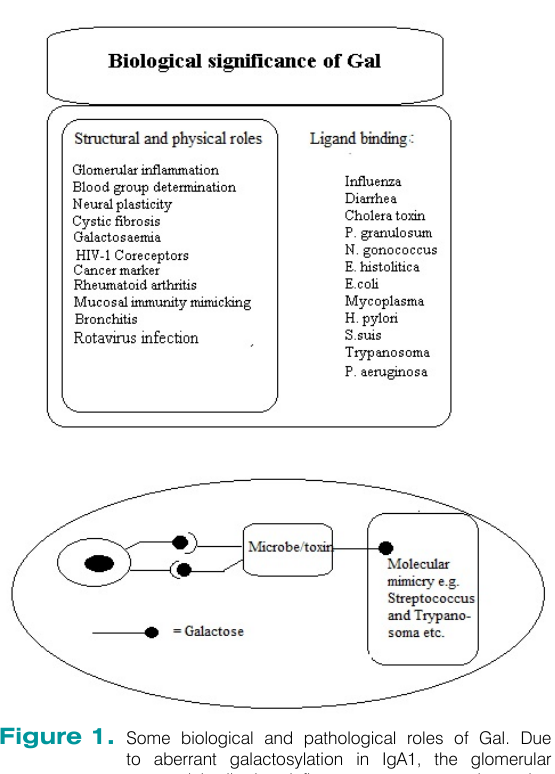
Figure 1. Some biological and pathological roles of Gal. Due to aberrant galactosylation in IgA1, the glomerular mesangial cells show inflammatory responses, by getting accumulation of IgA1-immune complex on glomerular mesangium. Terminal Gal and its derivatives are linked with the recognition of blood antigens. Fucosylation and galactosylation of blood group epitopes H epitope develop the Lewis blood group antigens, associated with the ligand binding of pathogens, toxins and selectins. High accumulation of fucosylated Gal in the form of Le antigens characterize the carcinoma development in different tissues of body. Sulfatide, a 3-O-sulfo galactosylceramide abundantly exists in myelin tissues and mediates the neuronal plasticity, protein trafficking and signal transduction. Galactosaemia, cystic fibrosis, bronchitis, molecular mimicking and rheumatoid arthritis are also specifically regulated by the Gal carrying oligosaccharide